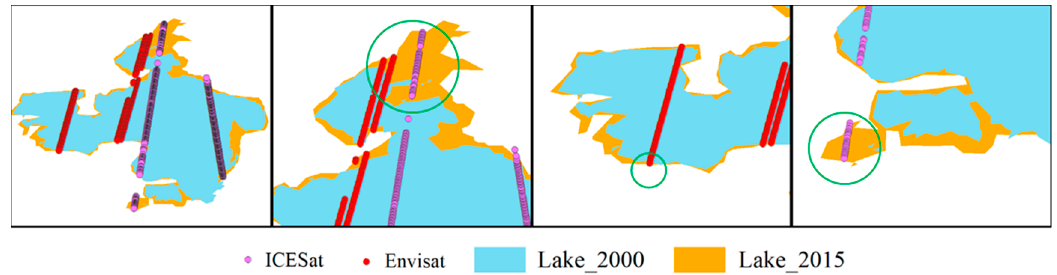
Figure 2. ICEsat and Envisat ground tracks on Selin Co. The green circles cover some altimeter footprints fell on the lakeside in 2000, while on the lake surface in 2015.